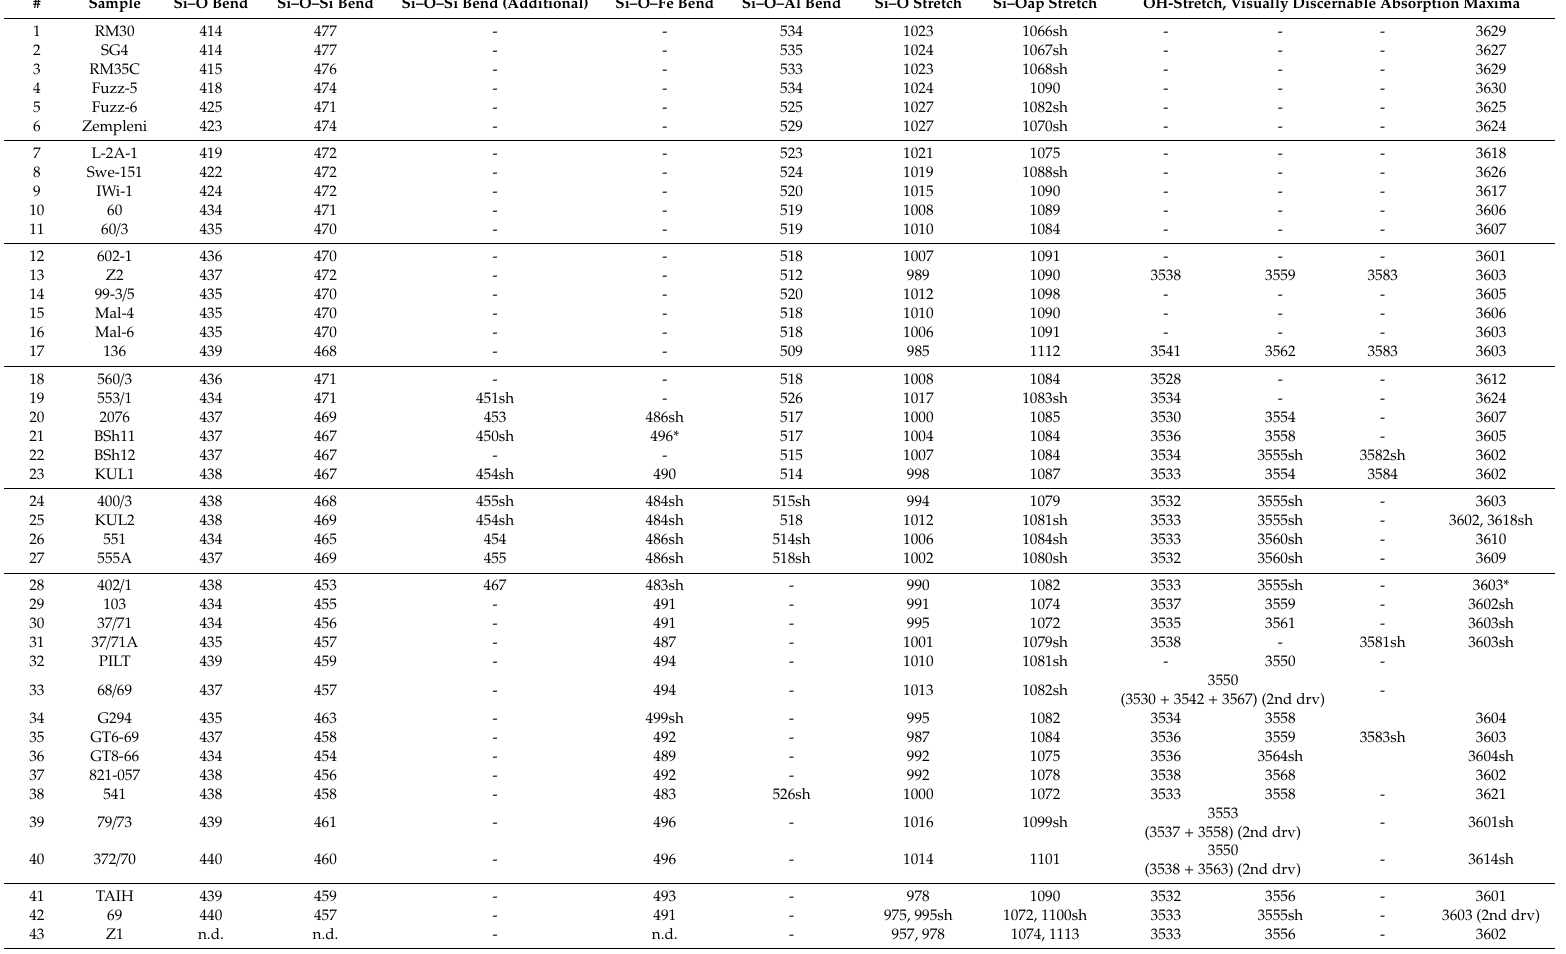
Table 3. Characteristic band positions (cm − 1 ) in the Si–O bending, Si–O stretching, and OH-stretching regions in the FTIR spectra of K-dioctahedral 1 M